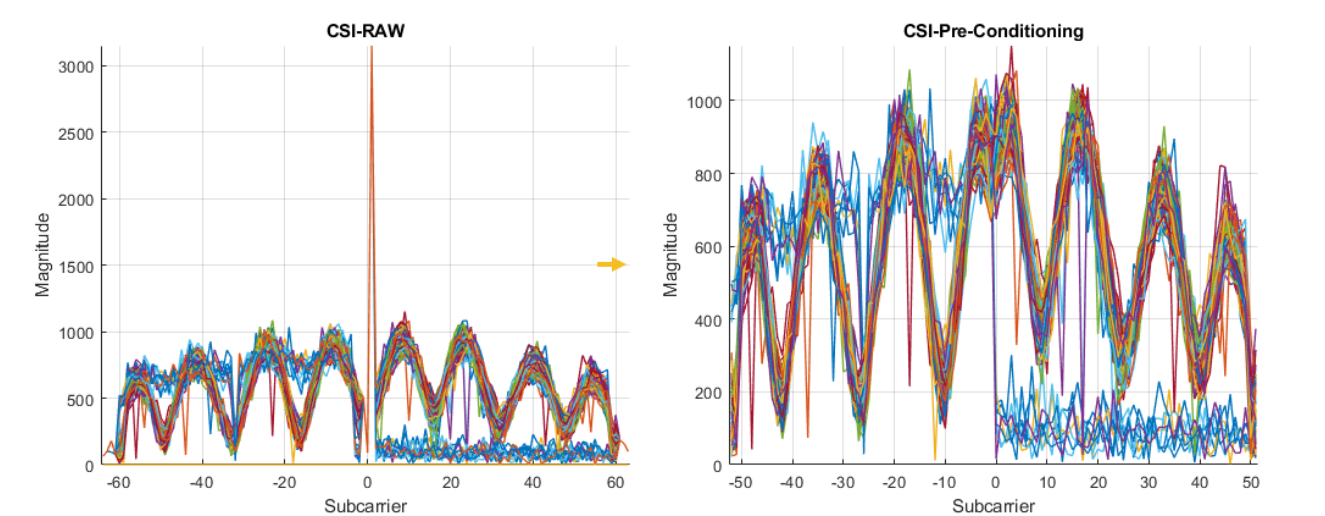
Figure 4. CSI raw and CSI precond data.